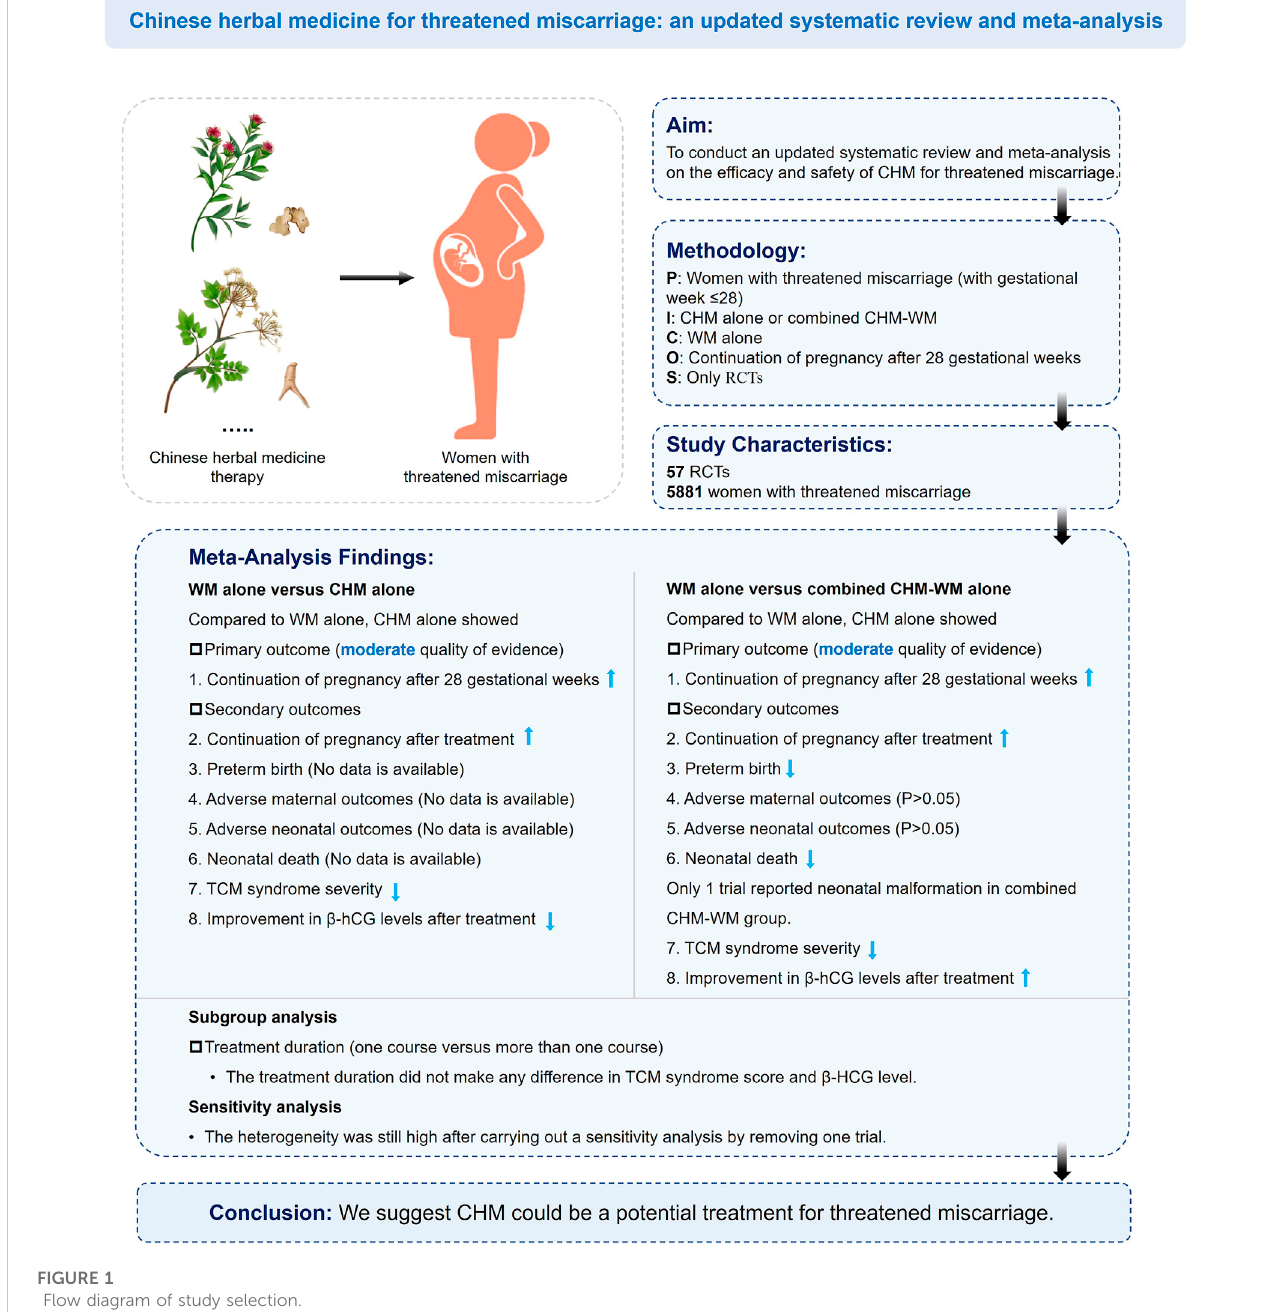
FIGURE 1 Flow diagram of study